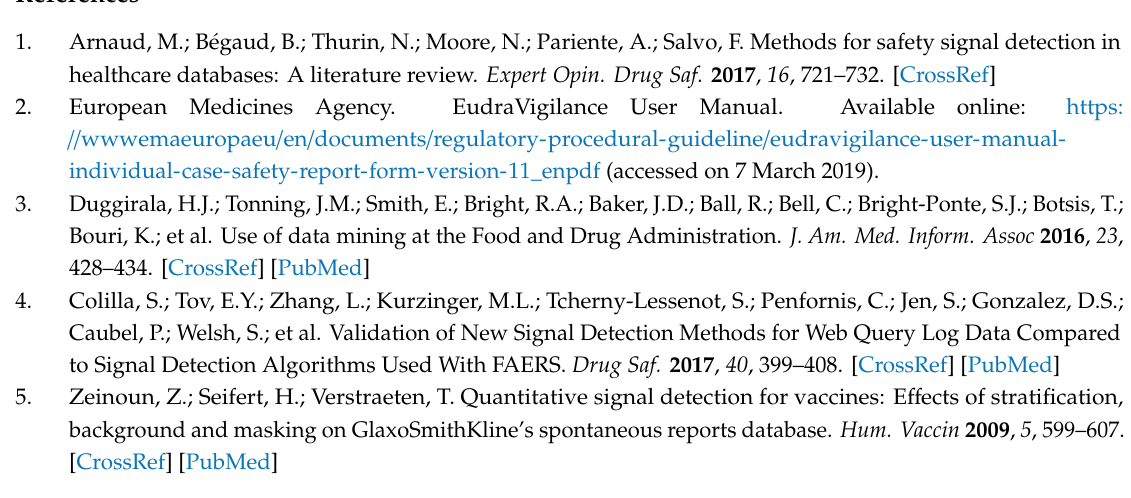
Figure S1: Detailed formula used for the performance evaluation using a confusion matrix, Table S1: List of vaccines in Korea Institute of Drug Safety & Risk Management-Korea Adverse Event Reporting System Database, Table S2: Subgroup analysis for the frequency of adverse events for pneumococcal vaccine and all other vaccines from 1988 to 2017, Table S3: Subgroup analysis for signal detection of pneumococcal vaccine using the disproportionality methods, empirical Bayes geometric mean, and tree-based scan statistic from 1988 to